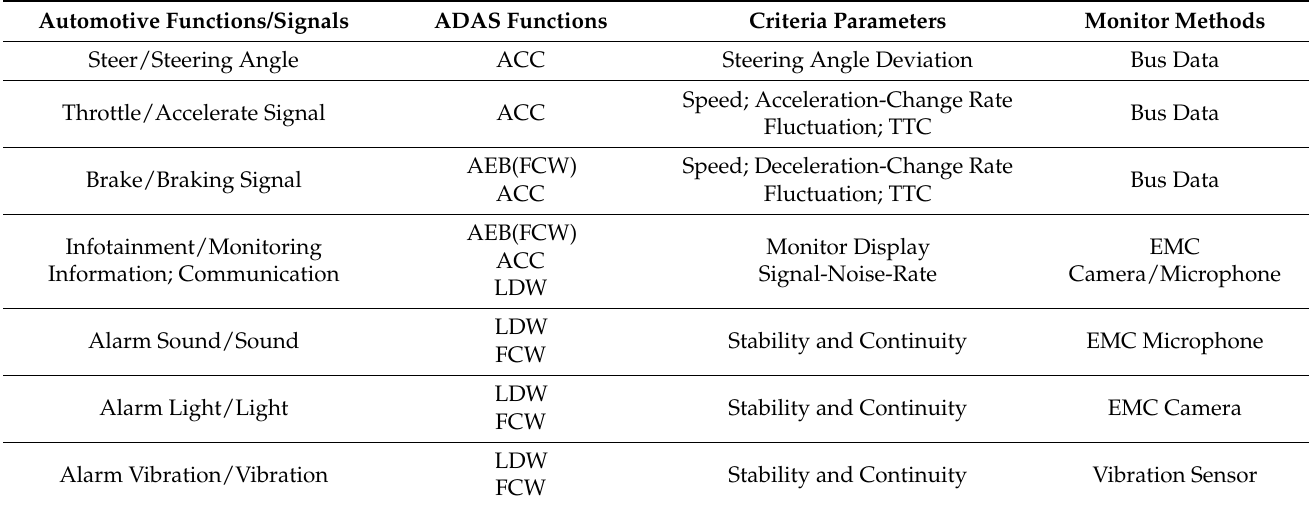
Table 1. Main Signal Classifications and criteria.